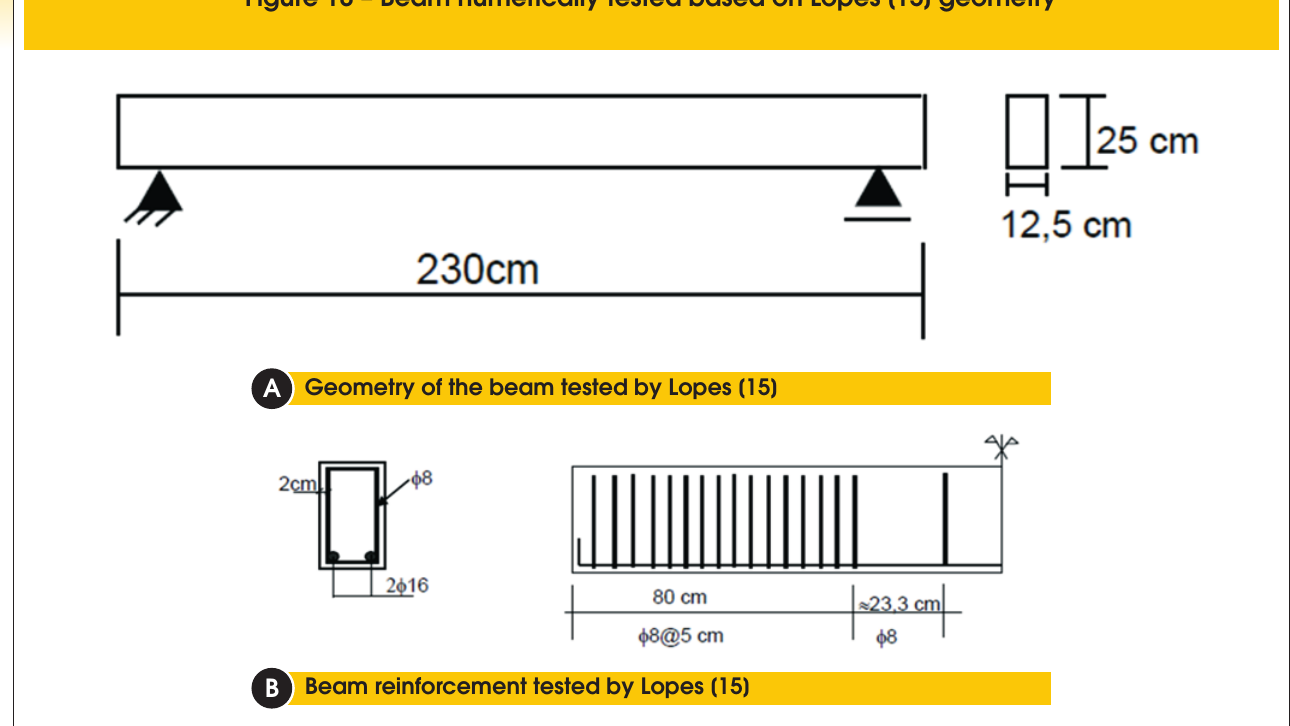
Figure 10 – Beam numerically tested based on Lopes [15] geometry